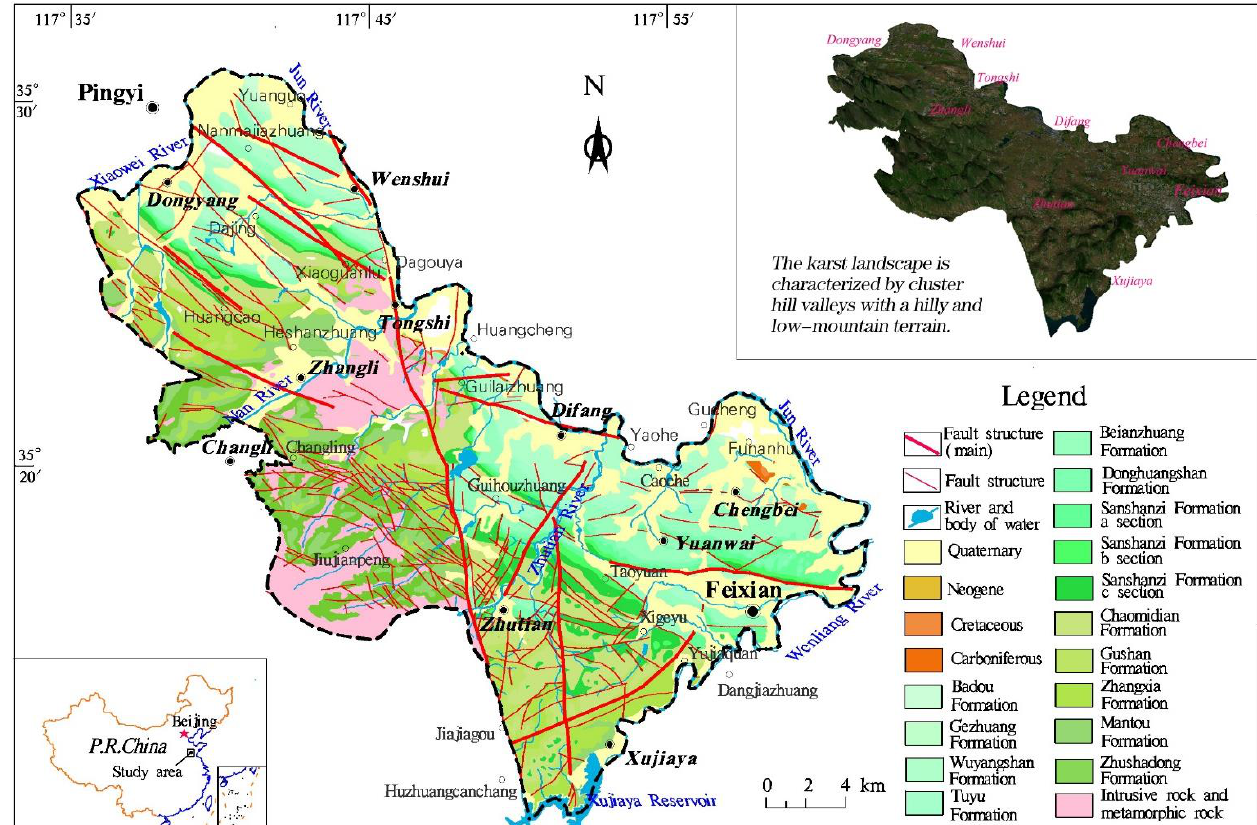
Figure 1. Geological structure map of the study region.